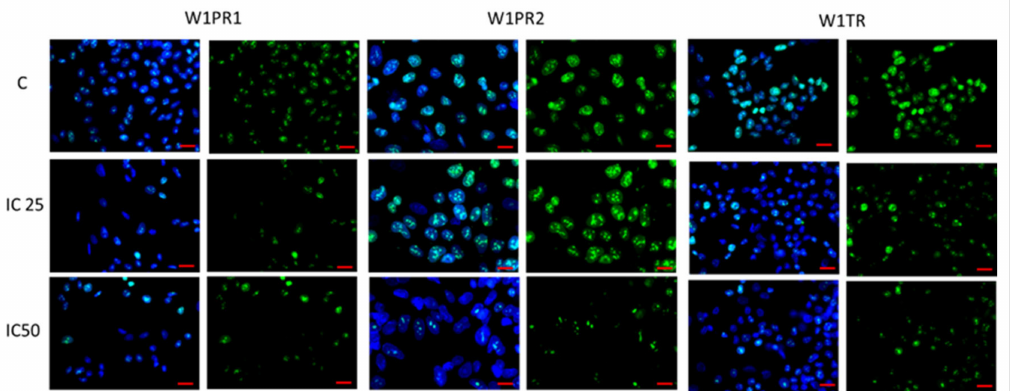
Figure 12. Immunofluorescence visualization of Ki67 expression in PAC and TOP-resistant cell lines after piperine treatment. Ki67 was detected using the anti-Ki67 antibody and an Alexa Fluor ® 488-conjugated secondary antibody (green). Cell nuclei were stained with DAPI (blue). C row means control (cells without piperine), IC25 and IC50 are showing the cells treated in appropriate concentration of piperine for 72 h. The first column shows both DAPI (blue) and protein signal (green), the second column shows protein signal alone, and so for each cell line. Scale bar = 2- µ m.